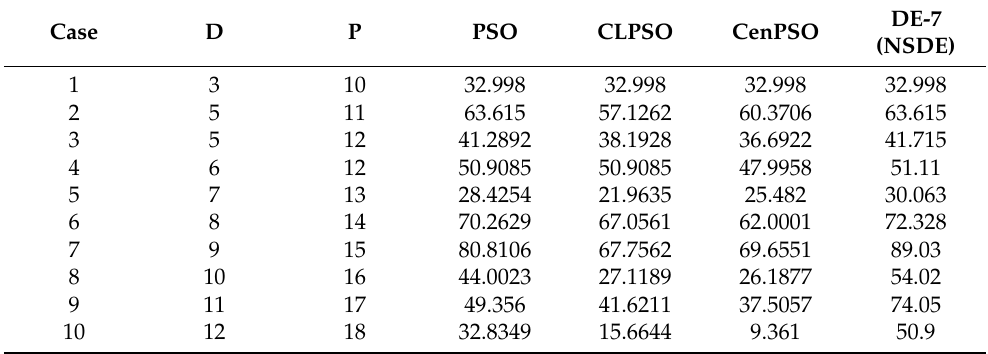
Table 12. Fitness function values for discrete PSO, CLPSO, CenPSO, and DE-7 (NSDE) algorithms with NP = 30; r D = r P = 0.1.